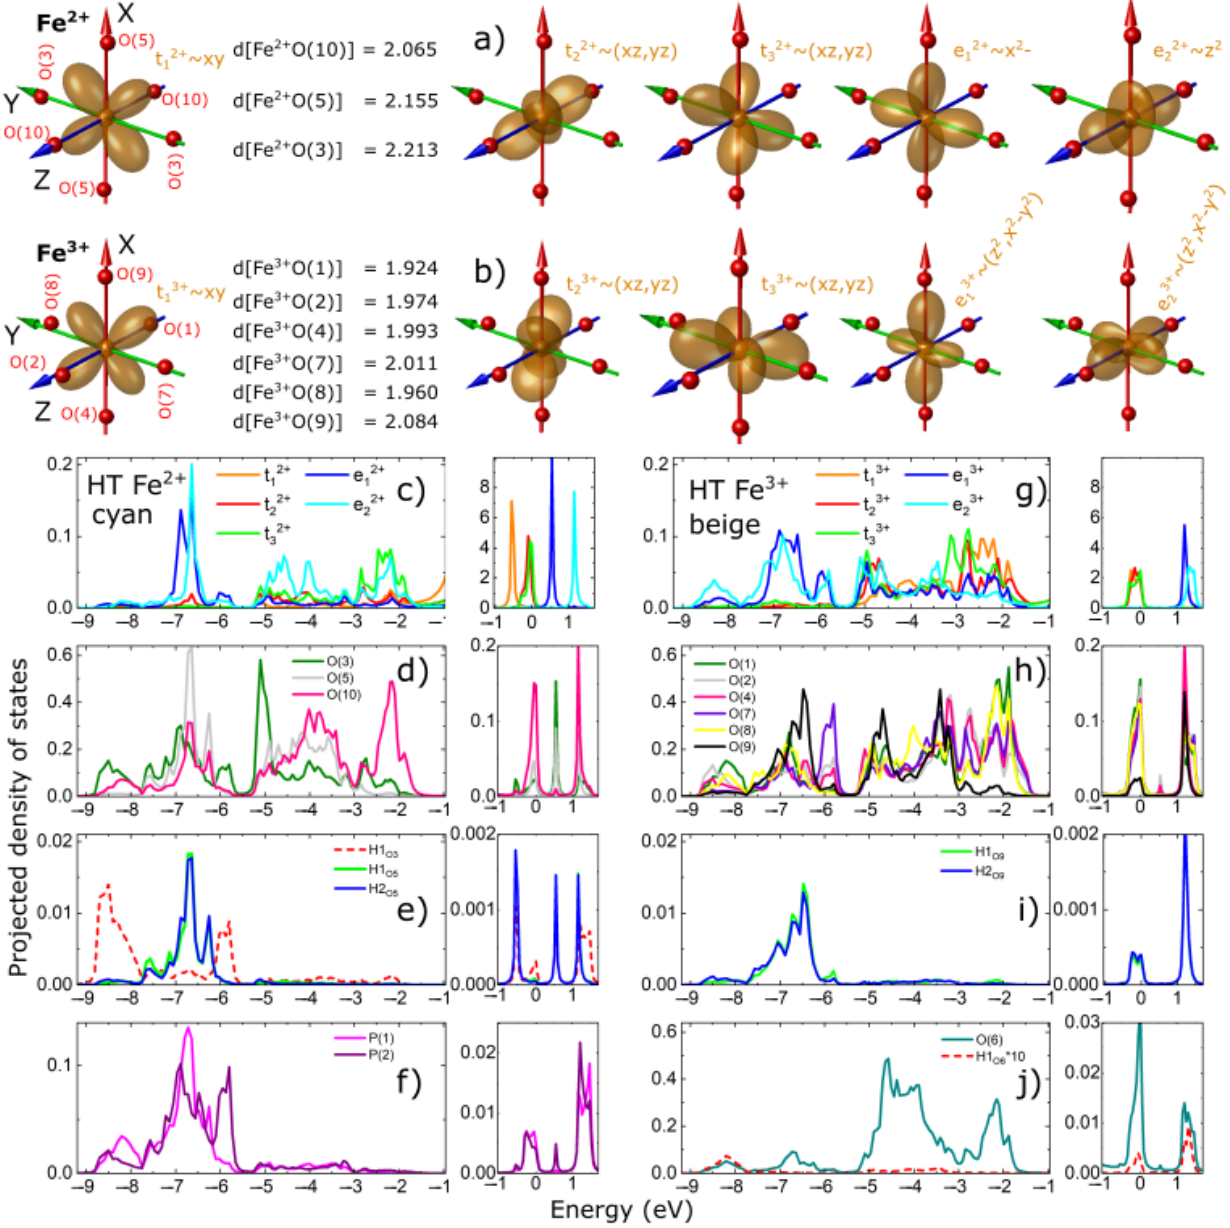
Figure 7. Projected density of states for the atoms of the HT unit cell: Panels ( a,b ) show a schematic representation of the XYZ Cartesian coordinate system constructed to best fit the directions of the oxygen ions; the oxygen ions are represented by the red spheres and labeled according to Tables 2 and 3; the t and e orbital are labeled by 2 + or 3 + depending on whether they correspond to Fe 2+ or Fe 3+ . For each orbital, we show the contributions from the real orbitals, for example, t 22+ ~(xz, yz) means the second orbital of the Fe 2+ for which the t 2 orbital is a linear combination of the real xz and yz orbitals. Panels ( c – j ) show the projected density of states for the Fe-d, O-p, P-p and H-s atoms. Fermi energy is represented by the 0 value on the energy axis.